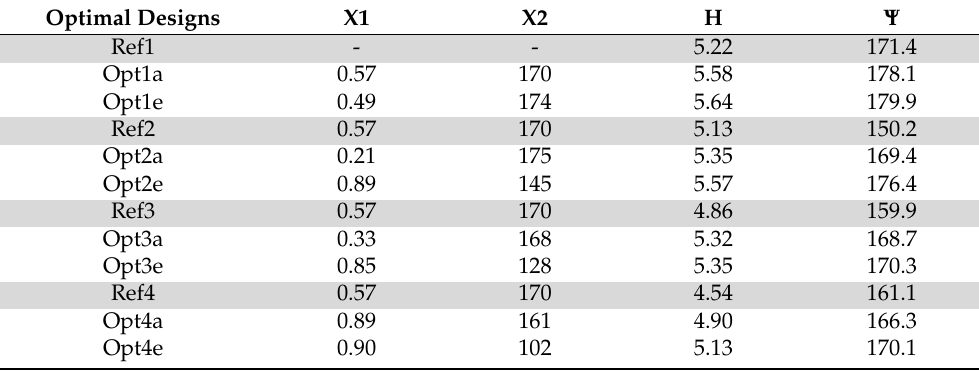
Table 6. Final optimal designs for maximum head and minimum input